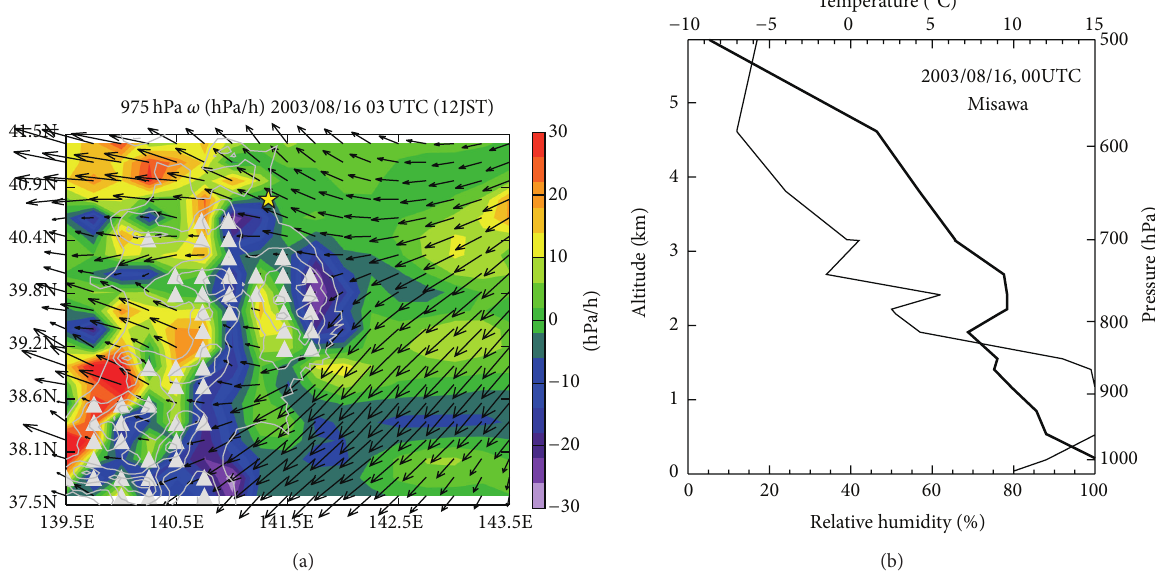
Figure 6: Same as Figure 2 but at 0335 UTC August 16, 2003.